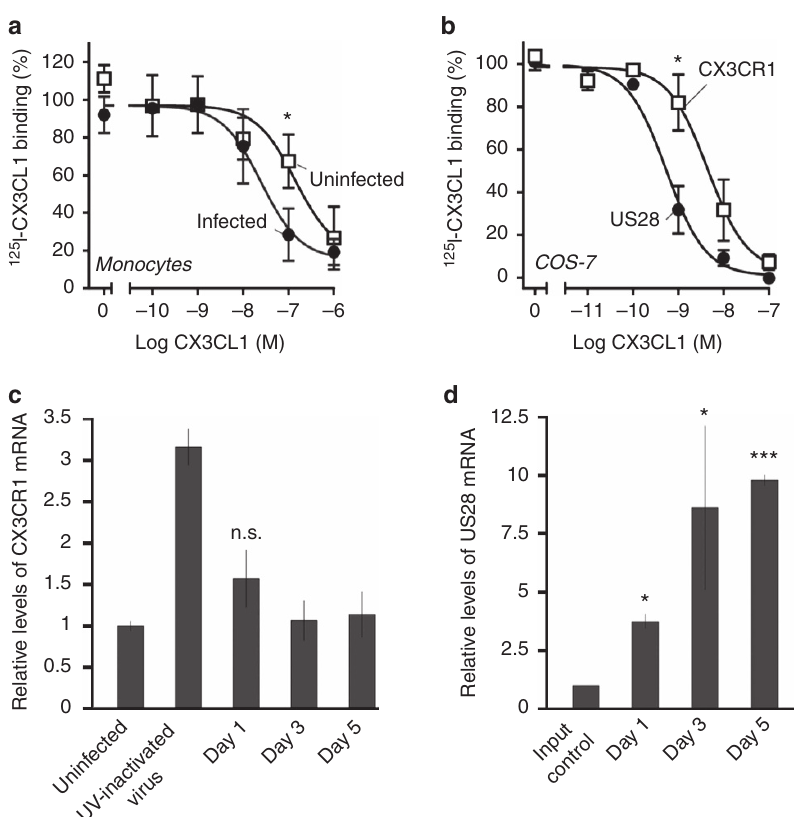
Figure 3 | Latently infected monocytes have high affinity for CX3CL1 that indicates cell surface US28 expression. Homologous competition binding on COS-7 cells and monocytes. ( a ) Binding of 125 I-CX3CL1 to uninfected (white symbols) and sorted, GFP-positive (latent) HCMV-infected monocytes (black symbols). The data are normalized to maximal binding on infected cells. Error bars indicate s.e.m. for five independent biological replicates. ( b ) Binding of 125 I-CX3CL1 to transiently transfected COS-7 cells expressing US28 (black) and CX3CR1 (white symbols). The data are normalized to maximal specific binding on US28-expressing cells. Error bars indicate s.e.m. for three independent biological replicates. ( c ) RT-qPCR analysis of CX3CR1 mRNA expression in monocytes latently infected at an MOI of 5, with SV40-GFP-TB40E, or monocytes treated with UV-inactivated virus, relative to an uninfected control. UV-inactivated virus samples were taken 1 day post infection. Means and s.d. values are shown from three measurements and normalized to GAPDH. ( d ) RT-qPCR analysis of US28 mRNA expression in monocytes latently infected at an MOI of 5, with SV40-GFP-B40E, relative to mRNA harvested immediately after infection (input control). Means and s.d. values are shown from three measurements and normalized to GAPDH. Statistical analyses were carried out using a paired two-tailed t -test and P values expressed as * P ¼ 0.05 or *** P ¼ 0.001 were considered Fig. 3a, CX3CR1 showed no significant increase in expression. Taken together, these data are consistent with the view that US28 is expressed on the cell surface of latently infected monocytes.